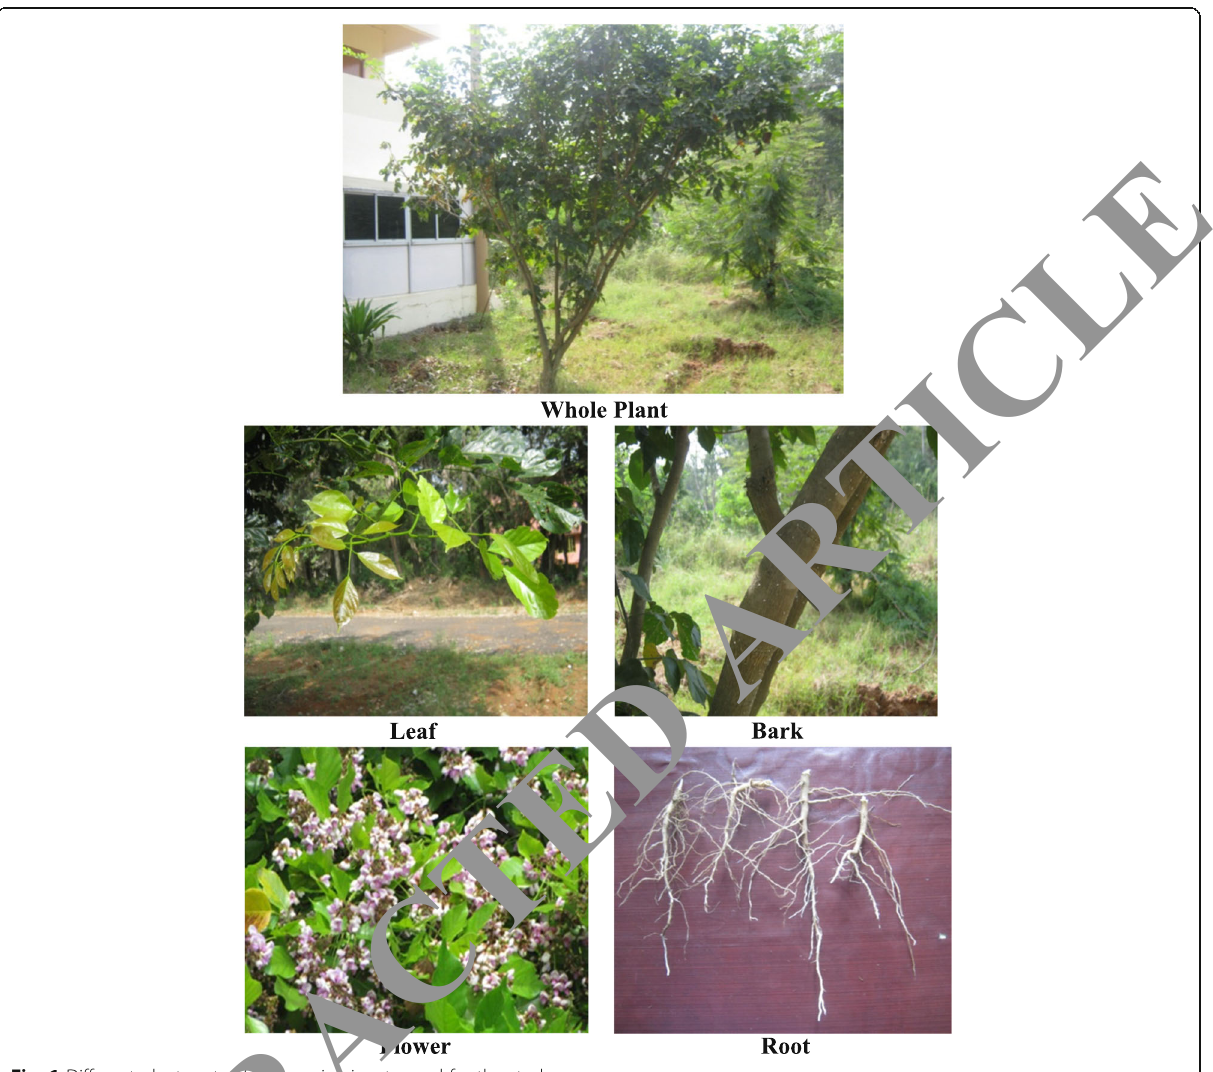
Fig. 1 Different plant parts of Pongamia pinnata used for the